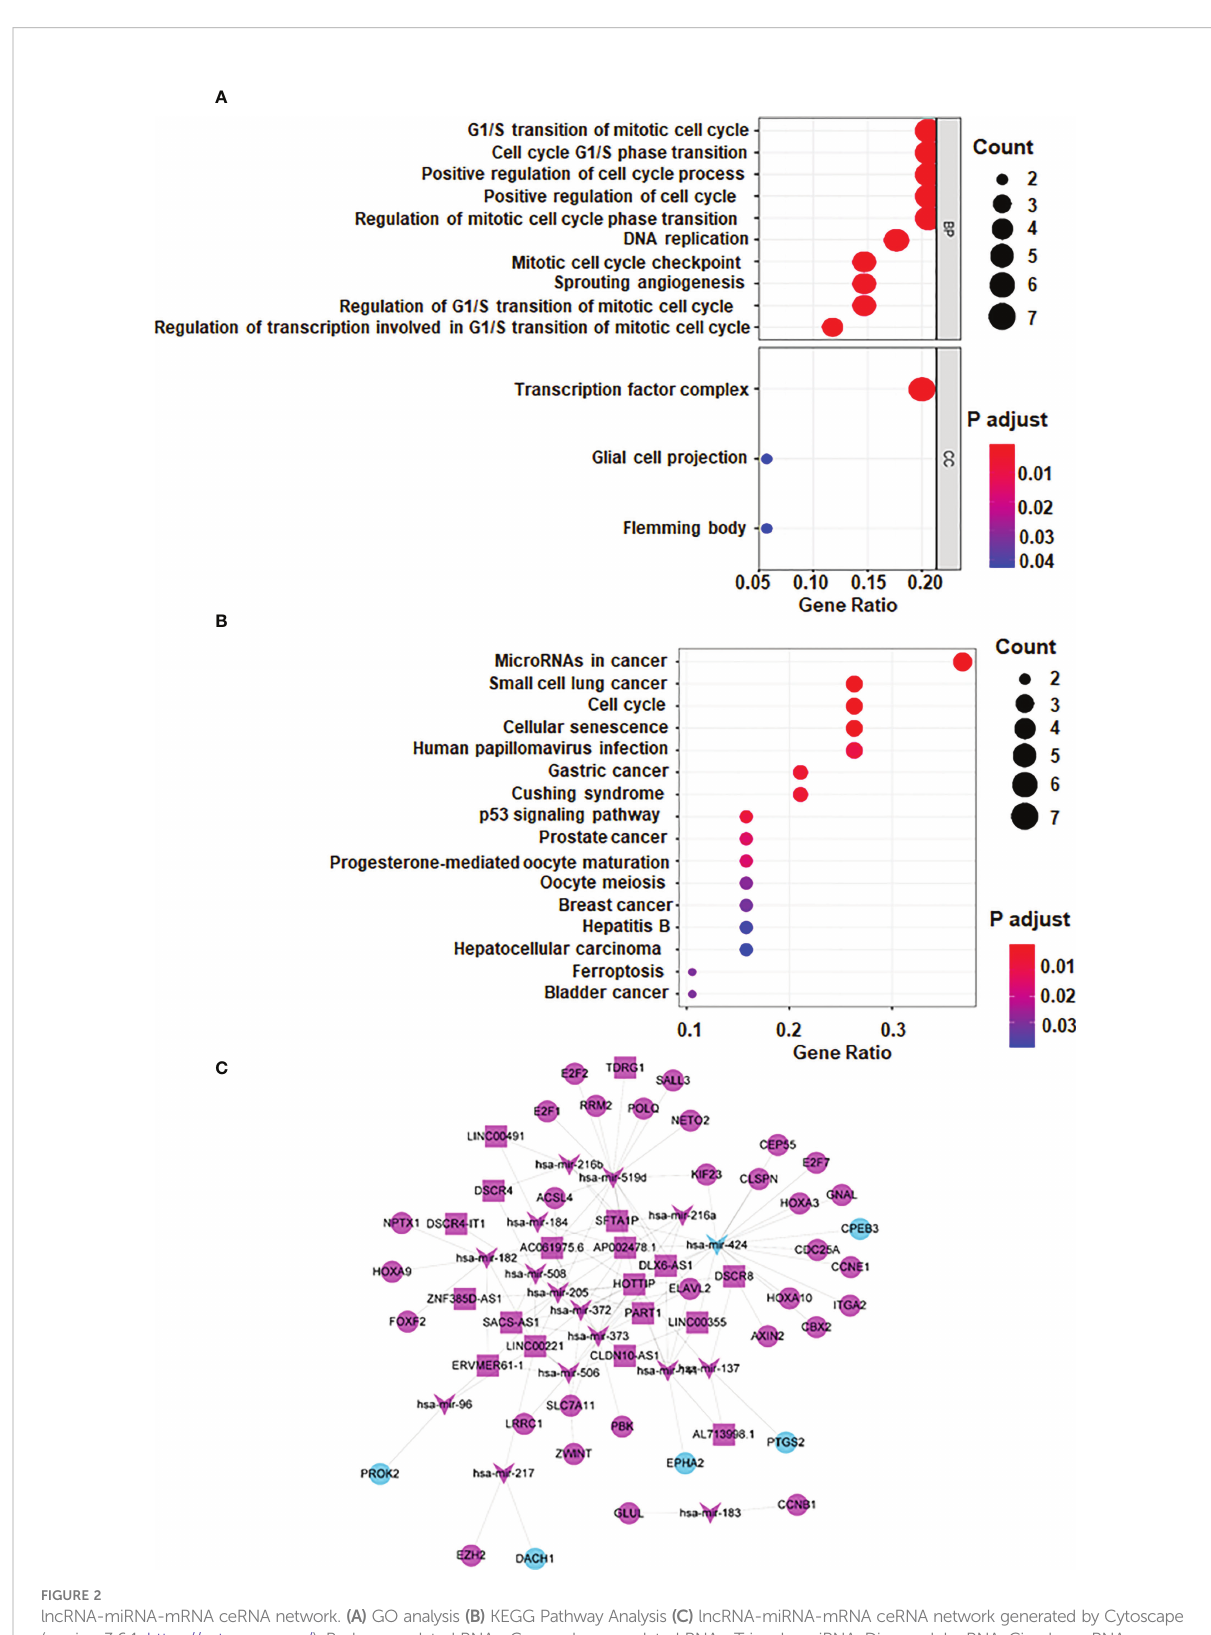
FIGURE 2 lncRNA-miRNA-mRNA ceRNA network. (A) GO analysis (B) KEGG Pathway Analysis (C) lncRNA-miRNA-mRNA ceRNA network generated by Cytoscape (version 3.6.1, https://cytoscape.org/). Red: upregulated RNAs. Green: downregulated RNAs. Triangle: miRNA. Diamond: lncRNA. Circular: